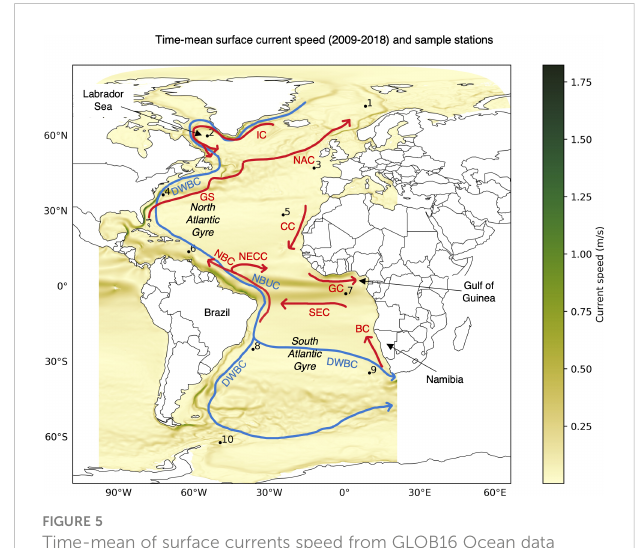
FIGURE 5 Time-mean of surface currents speed from GLOB16 Ocean data (2009-2018) and overview of surface (red) and deep (blue) currents adapted from Figure 1 of Bower et al. (2019). Sample station locations (Table 1) are also marked. BC: Benguela Current, CC: Canary Current, DWBC: Deep Western Boundary Current, GC: Guinea Current, GS: Gulf Stream, IC: Irminger Current, NAC: North Atlantic Current, NBC: North Brazil Current, NBUC: North Brazil Undercurrent, NECC: North Equatorial Counter Current, SEC: South Equatorial